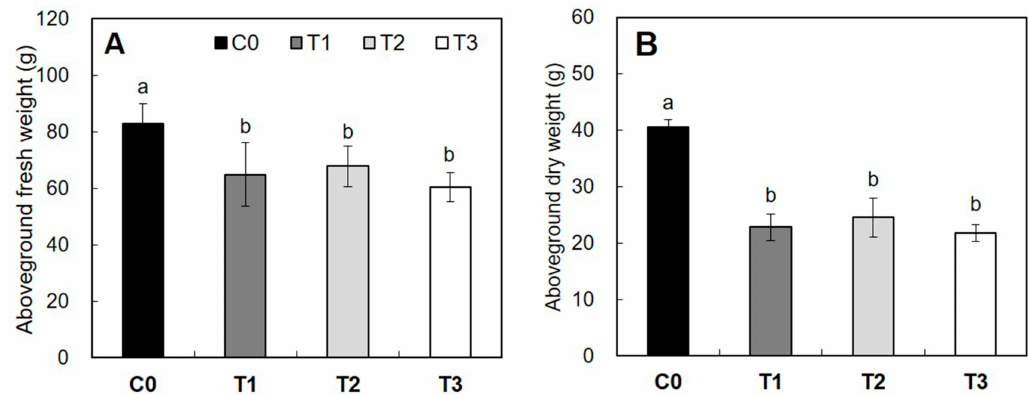
Figure 11. Aboveground fresh and dry weight in yellow-poplar exposed to artificial night lighting. ( A ) Fresh weight and ( B ) dry weight in yellow-poplar exposed to the natural day/night cycle (C0, black bars) and the day/night with artificial lighting cycle (T1, T2, and T3 denote dark gray bars, light gray bars, and white bars, respectively). Data indicate mean ± SD ( n = 5). Different lowercase letters on the bars indicate significant differences among treatments (Tukey’s test after one-way ANOVA).